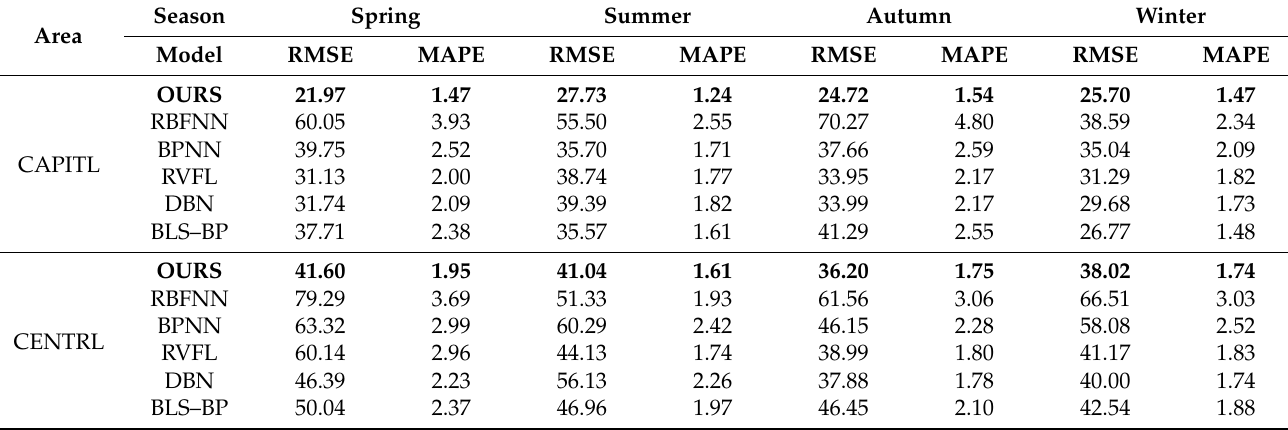
Table 2. The error of comparison with separate neural network